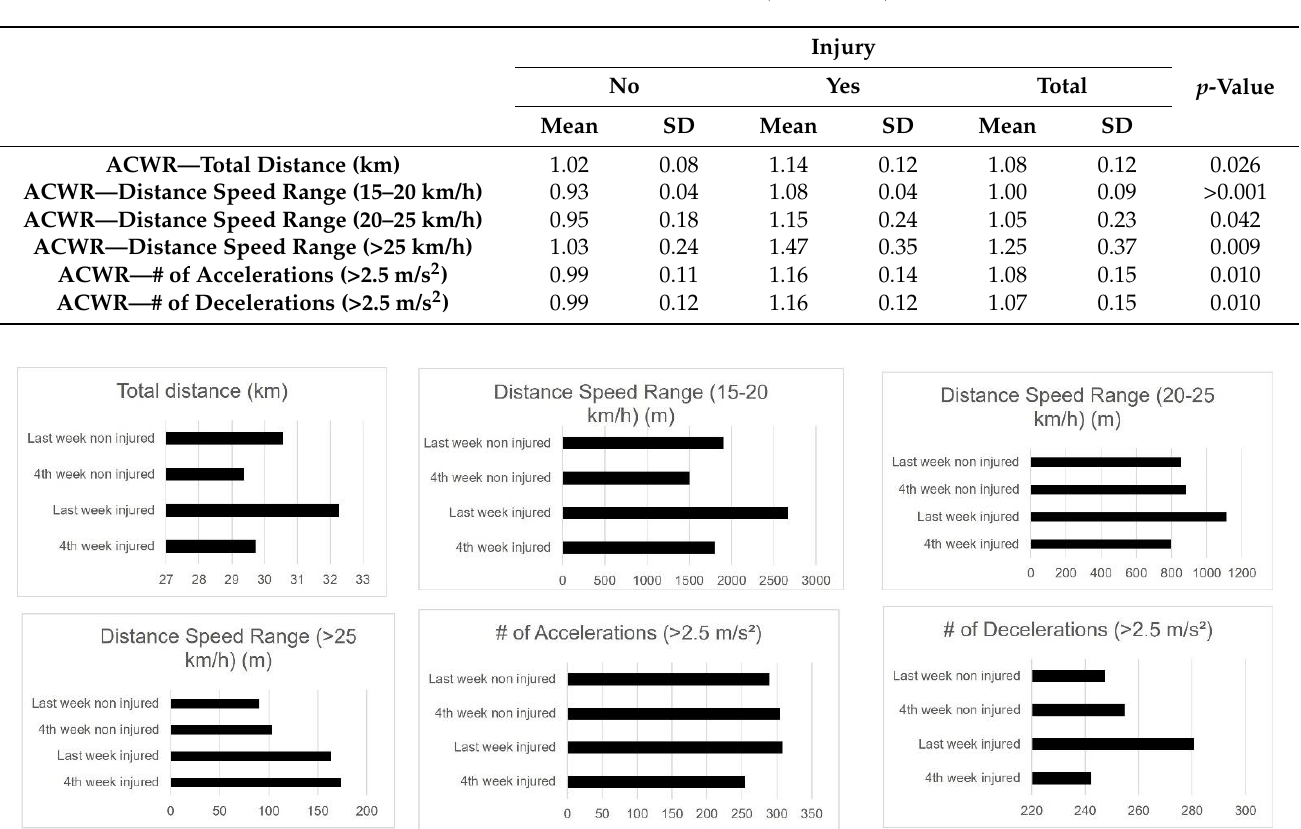
Table 2. ACWR values for two weeks model (mean ± SD).